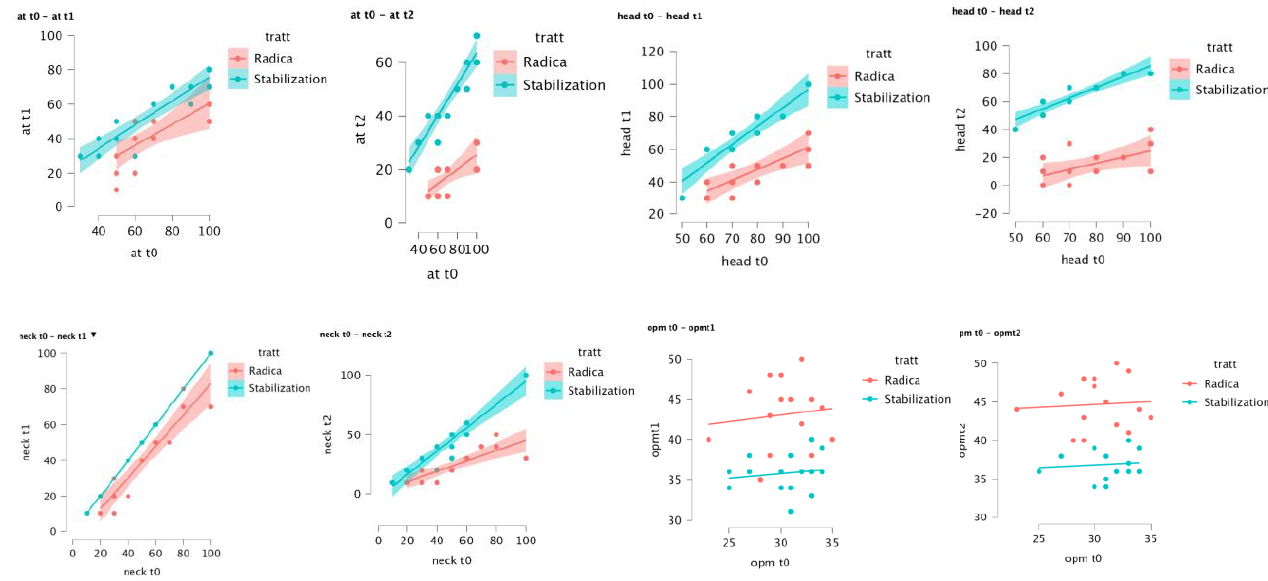
Figure 5. Plots from